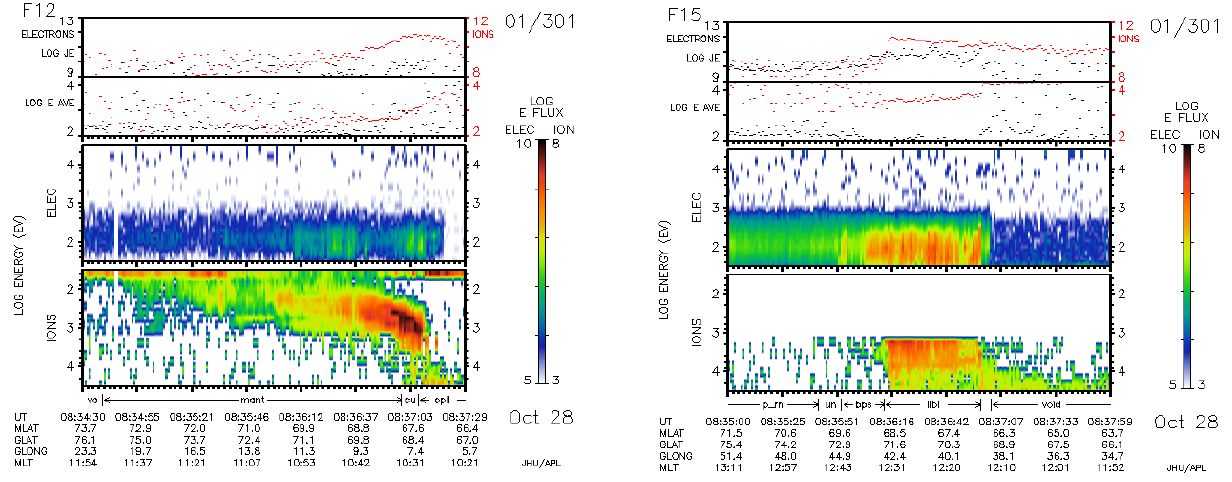
Fig. 2. DMSP data for precipitating particles over Spitsbergen and Kola peninsula. Also indicated are the boundaries of the magnetospheric regions.